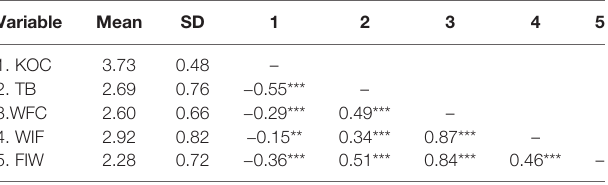
TABLE 2 | Means, standard deviations, and intercorrelations of the observed variables.